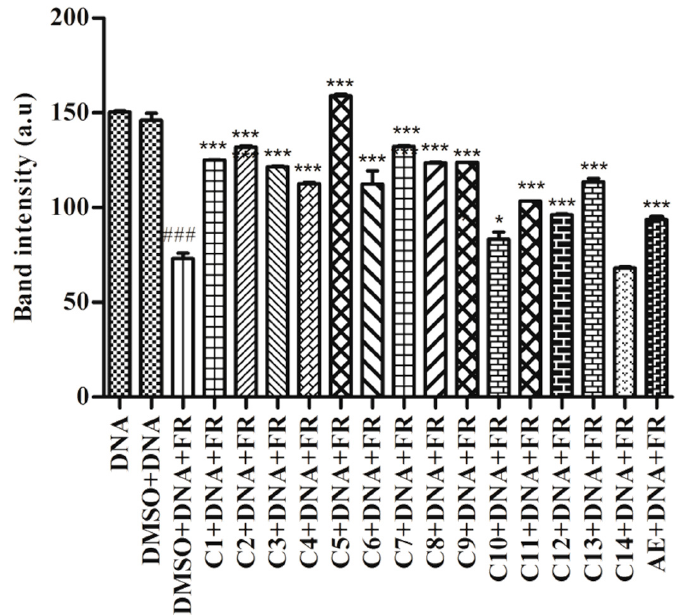
Figure 5. In vitro DNA damage assay. Compounds ( 1 – 14 ) and R. conduplicans. AE were incubated with DNA and Fenton’s Reagent and DNA damage was recorded with Agarose Gel electrophoresis. Respective graphical representation. ### p < 0.001; vs. control (DMSO + DNA). *** p < 0.001, ** p < 0.01, * p < 0.05; vs.DMSO + DNA + FR, One-way ANOVA followed by Tukey’s multiple comparison test was used to calculate values. Values are represented as mean ± SD, n = 3. AE = Acetone Extract, FR = Fenton’s Reagent.